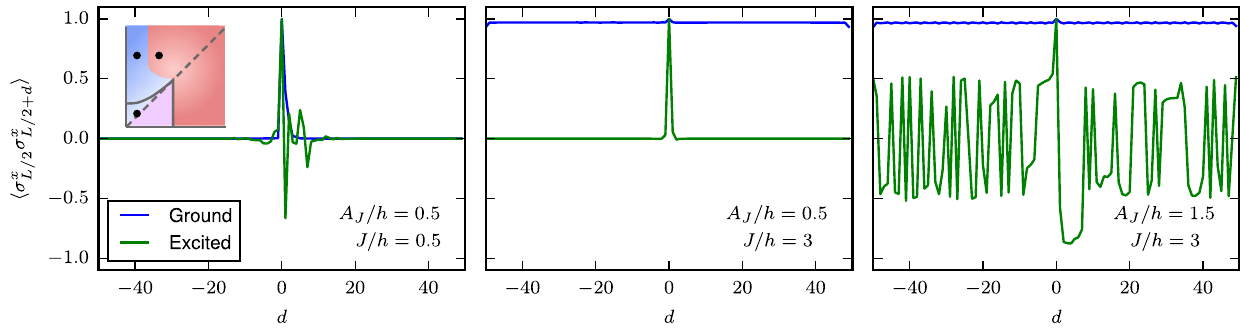
σ x FIG. 6. Spin-spin correlation function h σ x i as a function of the distance d from the center of the chain in an L ¼ 100 site chain L= 2 L= 2 þ d with open boundary conditions. The blue line is the ground state, while the green line shows a random excited state from the infinite- temperature ensemble. From left to right, the parameters are chosen so that the system is critically delocalized paramagnetic, extended ferromagnetic, and localized ferromagnetic, as indicated in the